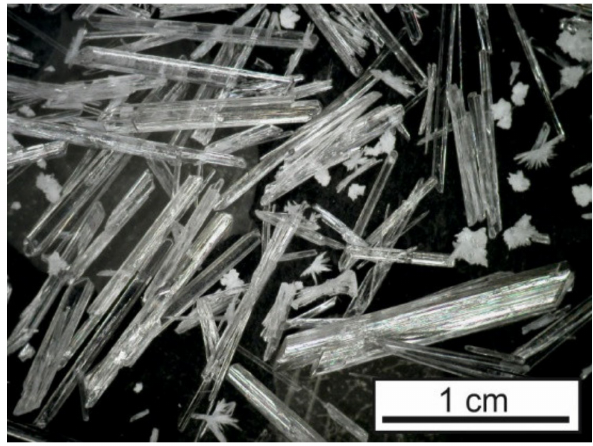
Figure 12. Clear untwinned crystals of gypsum, CaSO 4 · 2H 2 O, grown in silica gel with AlCl 3 additive.